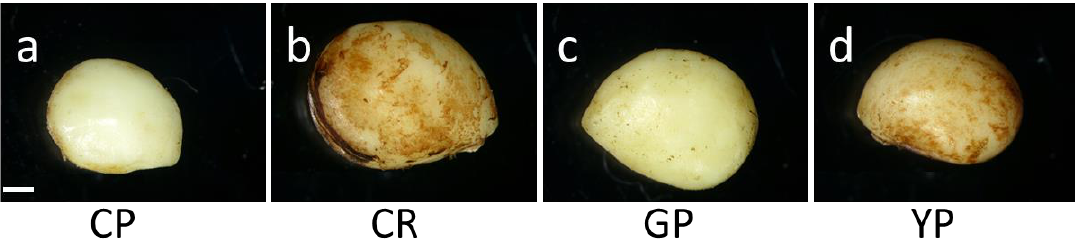
Figure 3. Morphological characteristics of dehiscent seeds depending on the cultivar of P. ginseng . After the stratification treatment for 90 days, the dehiscent seeds removed the seed coat. The seeds were evaluated for main characteristics, including weight, length, and diameter. ( a ) Chunpoong, ( b ) Cheonryang, ( c ) Gumpoong, and ( d ) Yunpoong. Scale bars, 1 mm. CP, Chunpoong; CR, Cheon- ryang; GP, Gumpoong; YP, Yunpoong.